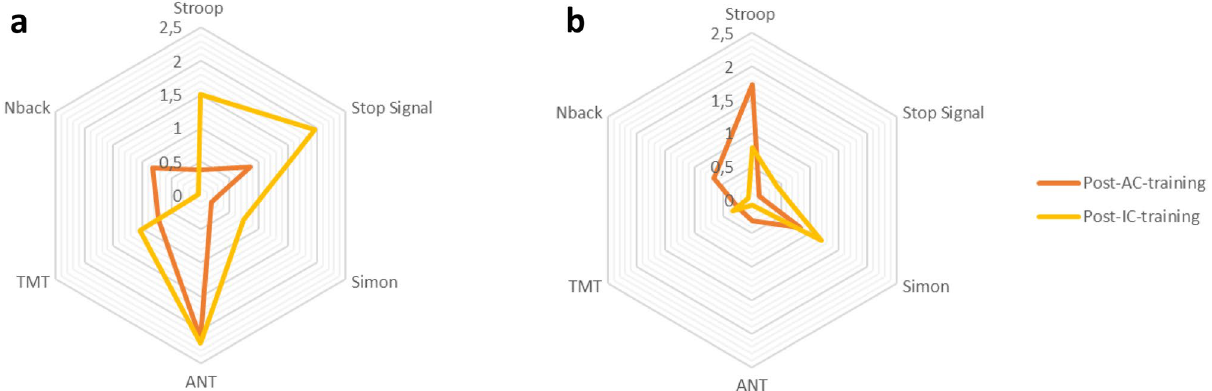
Figure 4. Relative changes in EF tasks after cognitive training in children ( a ) and adolescents ( b ). The radar graphs represent relative changes after inhibitory control (IC, in yellow) and active control (AC, in orange) training. Values correspond to − log(p), with p being the main effect of training in the repeated measures ANOVAs presented in Table